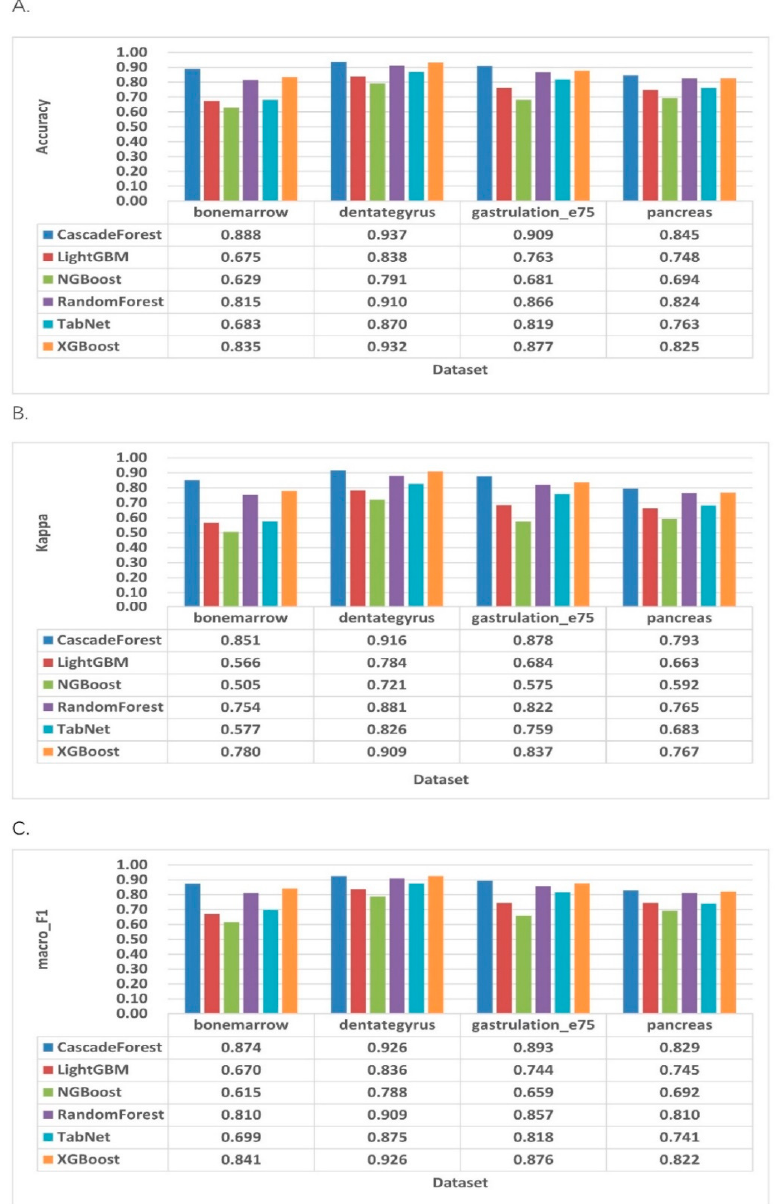
Figure 3. Evaluation of classification performance indicators for dynamic model RNA velocity prediction. ( A ) Accuracy of the classifiers. ( B ) Macro_F1 of the classifiers. ( C ) Kappa coefficients of the